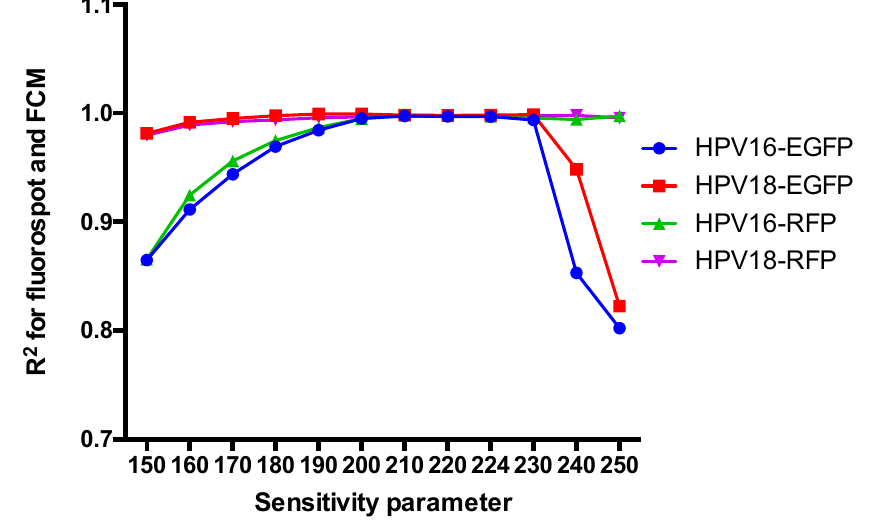
Figure 3. Effect of the sensitivity parameter on the correlation between the FluoroSpot and FCM results.